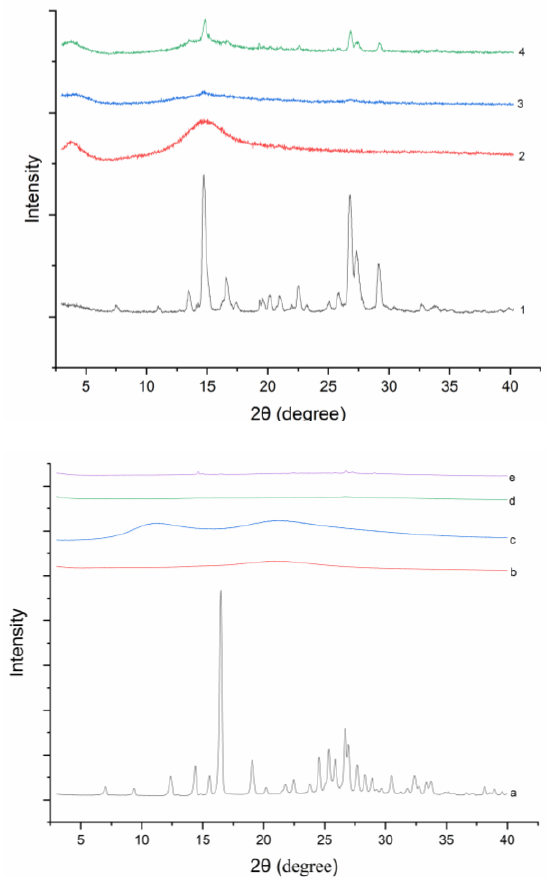
Figure 3. PXRD curves of (1, a) DNC, (2, b) GA, (3) DNC/GA SD, (4) DNC/GA PM, (c) PVP K30, (d) DNC/GA/PVP K30 SD, (e) DNC/GA/PVP K30 PM.